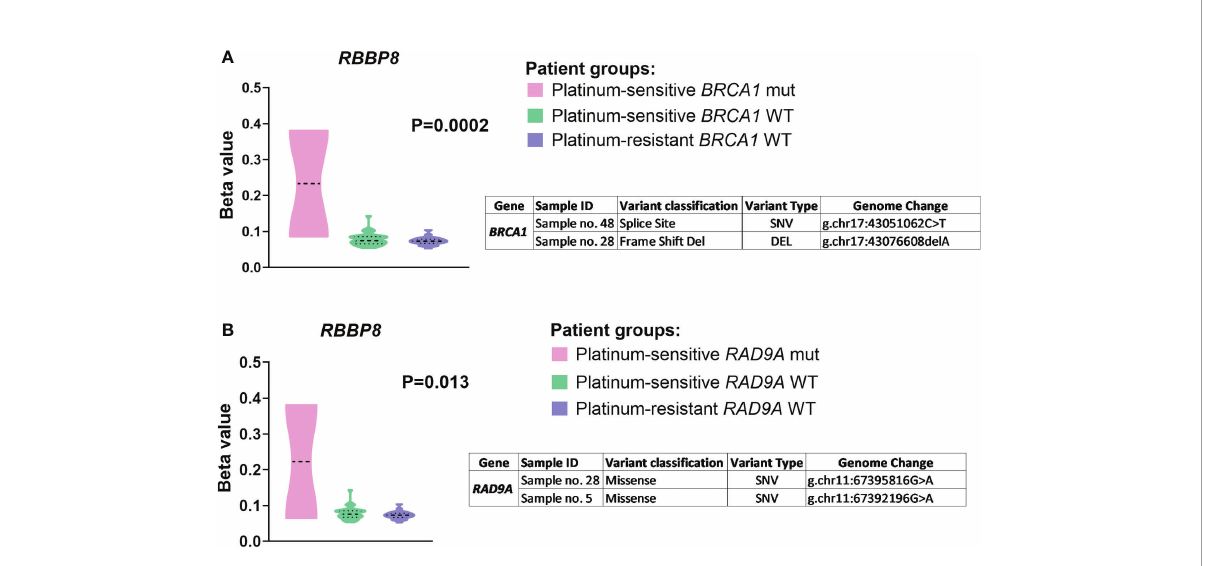
FIGURE 5 The RBBP8 methylation pro fi le divided by (A) BRCA1 and (B) RAD9A somatic mutations. Patients were strati fi ed to groups – platinum-sensitive harboring wild type BRCA1/RAD9A genes (N = 30, green color), platinum-resistant harboring wild type BRCA1/RAD9A genes (N = 20, purple color), and platinum-sensitive harboring mutant BRCA1/RAD9A genes (N = 2, pink color) based on the platinum resistance status determined by platinum-free interval (PFI). Displayed P values are after FDR correction. SNV (single nucleotide polymorphism/variant), DEL